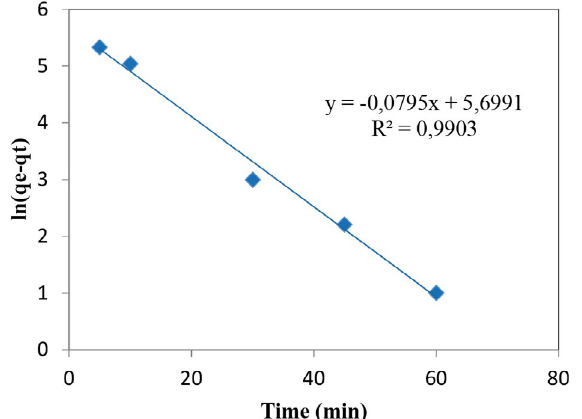
Figure 7. Lagergren kinetic model for Cr(VI) sorption onto isatin based Amberlite